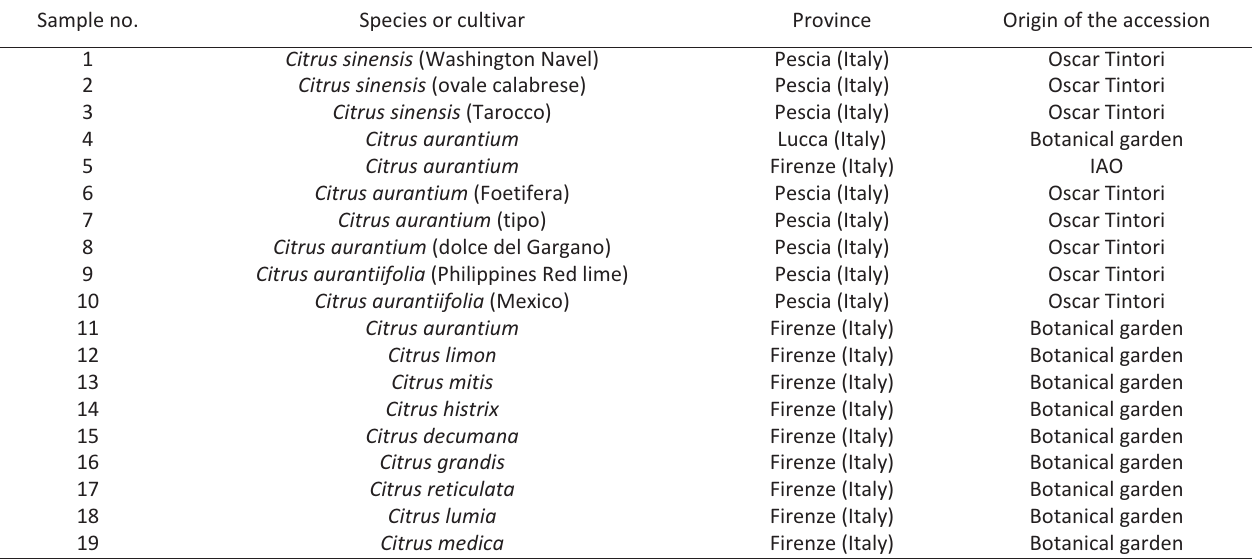
Table 2 - Citrus species used as control, coming from public and private collections